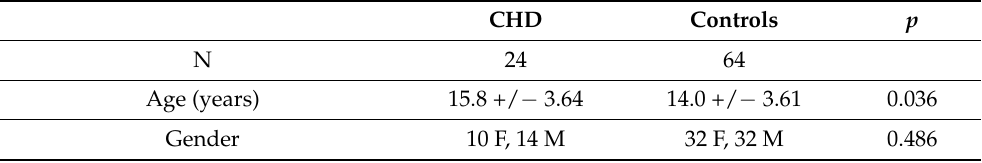
Table 1. Demographic and cognitive characteristics (NIH Toolbox scores) for the study population, consisting of subjects with congenital heart disease (CHD) and normal referents, as well as nasal nitric oxide measurements and maternal education levels for the subset of participants where those data were available (44 for nasal nitric oxide, 71 for maternal education). Maternal education was coded according to the following rubric: Doctoral/Professional degree = 7, Master’s degree = 6, Bachelor’s degree = 5, Associate’s degree = 4, Trade/technical/vocational training = 3, Some college = 2, HS graduate = 1, No HS diploma =